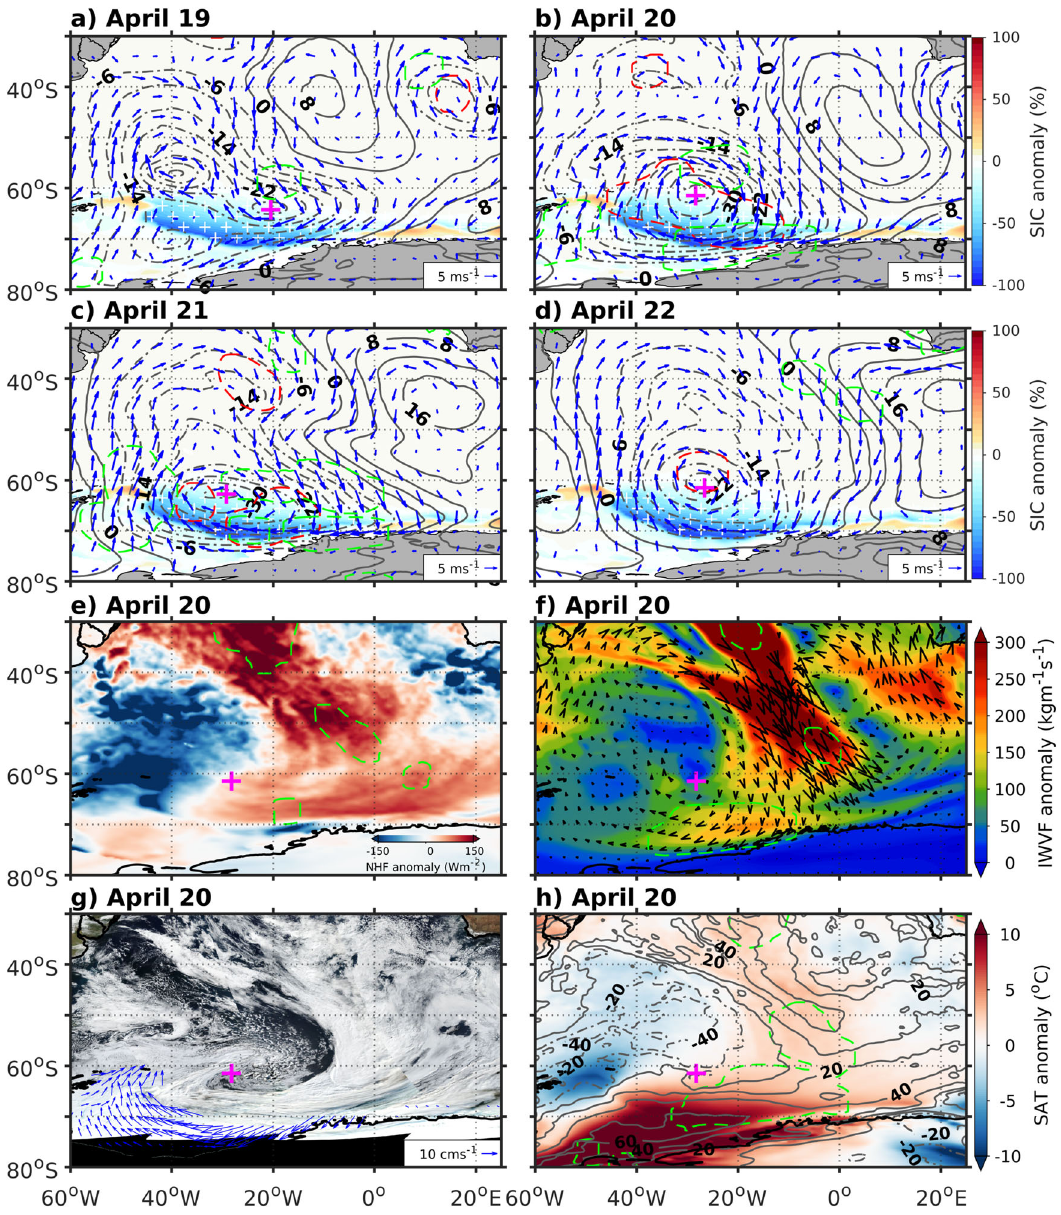
Fig. 5 Impact of the explosive cyclone C3 on sea ice. a – d Daily anomalies of mean sea level pressure (MSLP) and wind vectors (blue arrows) are overlaid on anomalous sea ice concentration (SIC) from 19 to 22 April 2019. Positive (negative) anomalies of MSLP are shown in solid (dashed) gray contours. The white plus marks showed the record low SIC values that remain outside from 1979 to 2020. e – h Anomalies in ( e ) net surface heat fl ux (NHF), ( f ) integrated water vapor fl ux (IWVF), ( g ) potential sea ice velocity (arrows) overlaid on cloud bands of cyclone from the Visible Infrared Imaging Radiometer Suite (VIIRS), and ( h ) downward long-wave radiation (gray contours) overlaid on surface air temperature (SAT) during explosive development on 20 April 2019. Regions within red (green) dashed polylines have record low (high) values that remain outside from 1979 to 2020. Within this, the record low is shown for MSLP, while the record high is shown for the other variables. The pink plus mark shows the low-pressure centre of the cyclone. The anomalies are computed relative to the climatology of 1979 – of wind waves and swells transferred momentum into the ice cover contributing to the break-up of the sea ice during the 2019) with strong north to north-westerly winds of up to 21.3 m cyclonic episode. Also, the sea surface was forced by strong s − 1 , which had a large fetch (Fig. 5a ‒ d, Supplementary Fig. 8c ‒ g). negative wind stress curl lower than − 0.5 × 10 − 5 N m − 3 during the The strong winds during this long period provided a favorable environment for the formation of high waves that was leaving the cyclone, which was conducive to upwelling and mixing of sub- fetch area as swell waves and propagated south-eastward into the surface warm water into the surface (Figs. 4a, 7a ‒ d). The upper marginal ice zone of the Weddell and Lazarev Seas (Fig. 6, ocean thermal structure showed anomalous warming of the SST Supplementary Fig. 9). The maximum SWH of ~7 m was generated and MLT up to 2.6 °C during the passage of cyclone C3 (Figs. 7, 4b, near the sea ice edge with an anomaly of ~3.3 m during 19 – 22 Supplementary Fig. 4b). As a result of extreme changes in ocean and atmospheric conditions during the lifetime of cyclone C3, the